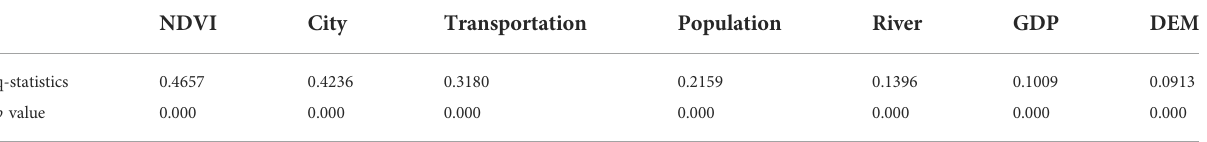
TABLE 4 Q-statistics table for the correlations between the various factors and the spatial distribution of scenic spots in Northwest China based on geographic detectors (scale size: 10 km × 10 km). NDVI City